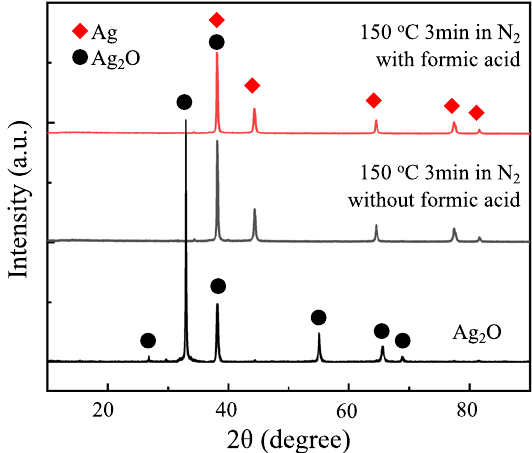
Figure 3. XRD patterns of the Ag 2 O paste sintered at 150 °C for 3 min in a flowing N 2 gas with or without the Pt-catalyzed formic acid vapor. Ag 2 O was used as a reference.